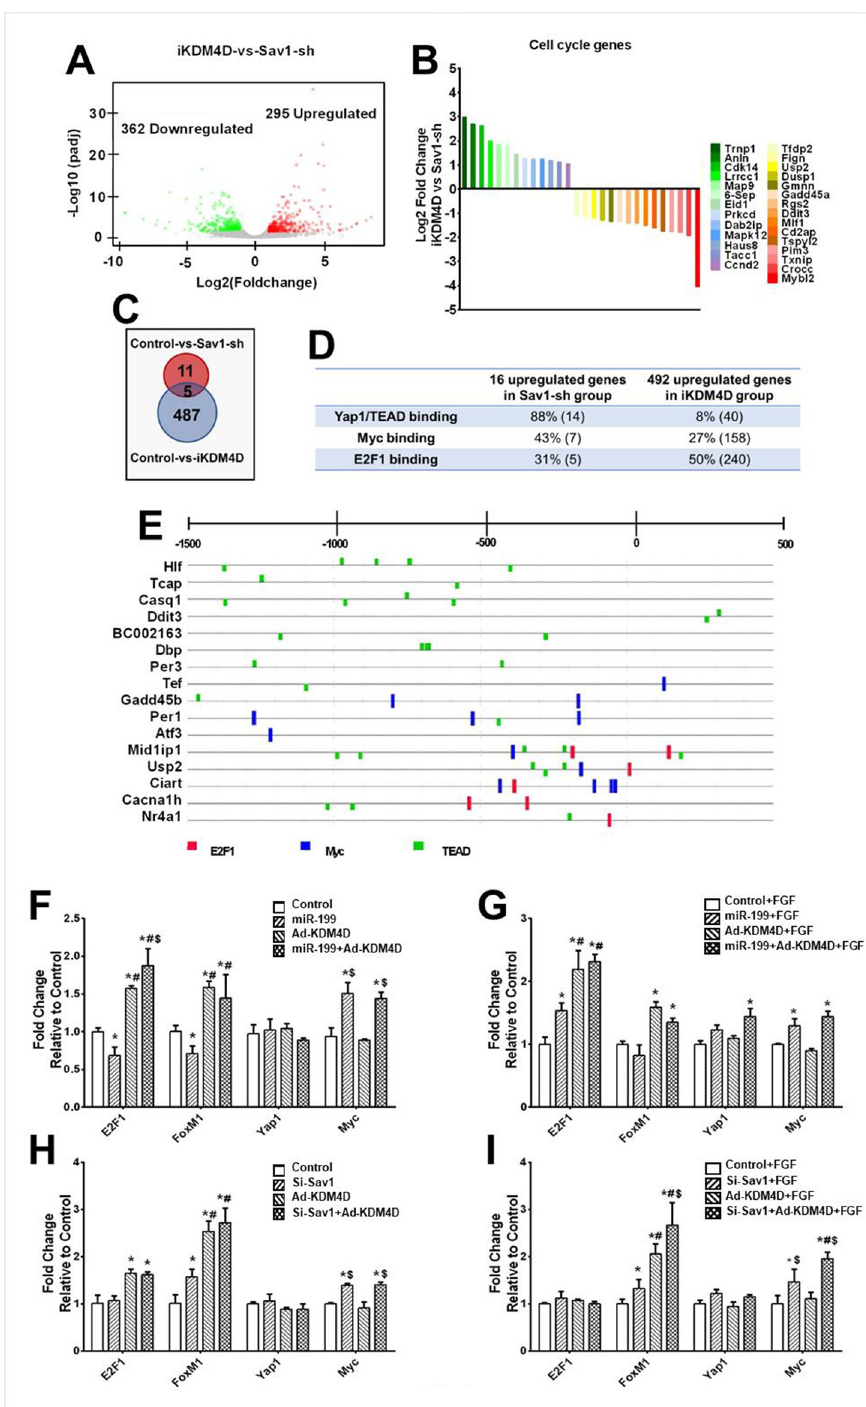
Fig 6. Transcriptional analysis of Sav1-sh and iKDM4D treated cardiac myocytes in vivo . (A) The global transcriptional change in the iKDM4D groups compared with Sav1-sh was visualized by a volcano plot. Each data point in the scatter plot represents a gene. The log2 fold change of each gene is represented on the x-axis and the log10 of its adjusted p-value is on the y-axis. Genes with an adjusted p-value less than 0.05 and a log2 fold change greater than 1 represent upregulated genes (red dots). Genes with an adjusted p-value less than 0.05 and a log2 fold change less than -1 represent downregulated genes (green dots). (B) Fold change of 28 cell cycle genes in iKDM4D group